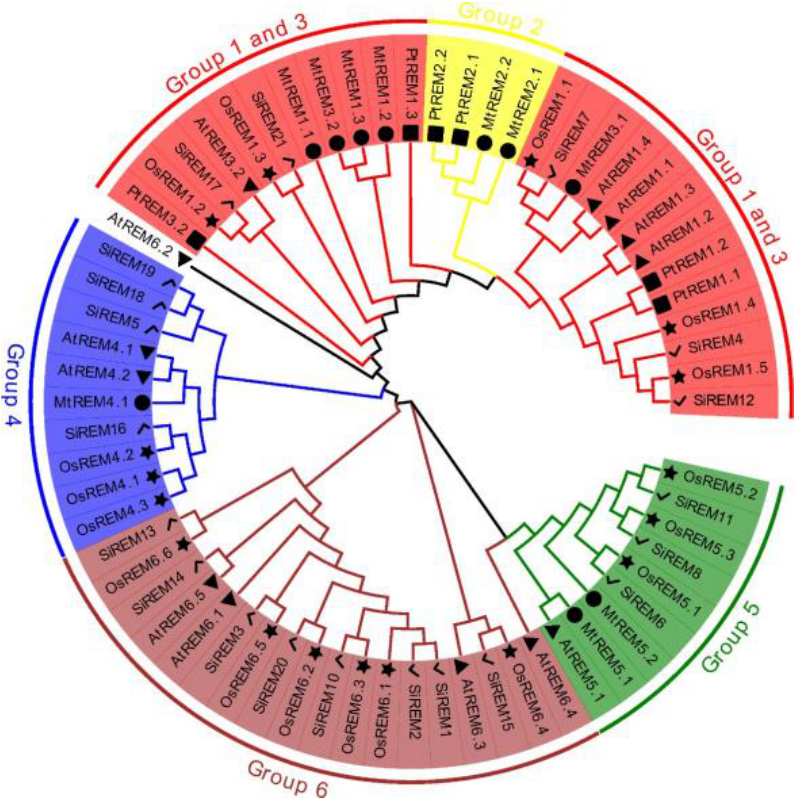
Figure 1. Phylogenetic relationships of remorin proteins. The phylogenetic tree was constructed from 66 protein sequences from Arabidopsis (13), M. truncatula (10), P. trichocarpa (6), rice (17), and foxtail millet (20), using the maximum likelihood method with 1000 bootstrap replicates. The lines of different colors indicate different groups. Triangles, circles, squares, stars, and check marks represent remorin proteins of Arabidopsis , M. truncatula , P. trichocarpa , rice, and foxtail millet, respectively.